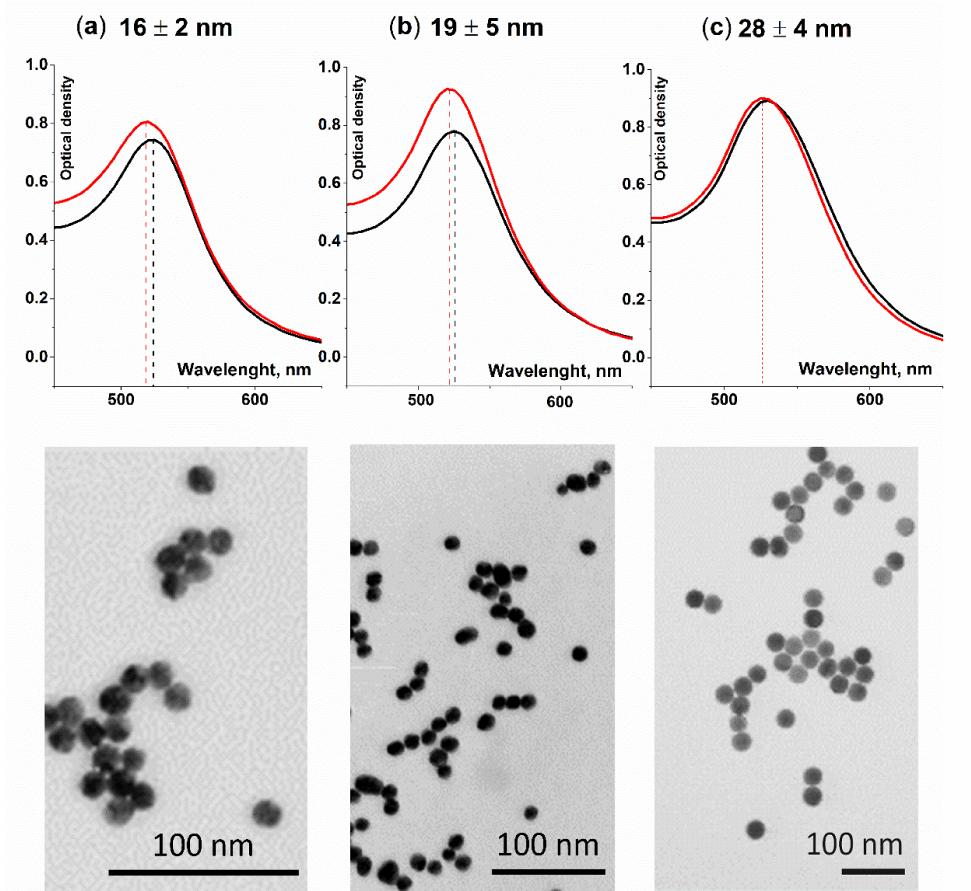
Figure 2. Absorbance spectra of AuNPs before (red line) and after (black line) stabilization of Tween-20 and TEM images. The AuNPs were synthesized using different amounts of reduction agent, as follows: ( a ) 3.75 mL of 1% sodium citrate solution, with an average particle size 16 ± 2 nm; ( b ) 2 mL of 1% sodium citrate solution, with an average particle size 19 ± 5 nm; ( c ) 1.5 mL of 1% sodium citrate solution, with an average particle size 28 ± 4